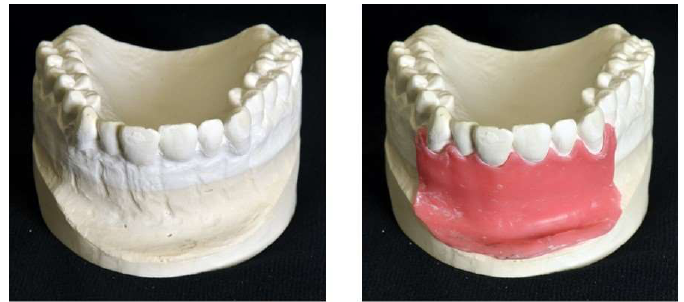
Figure 1. Modified plaster cast (left) and modified plaster cast with wax layer (right).